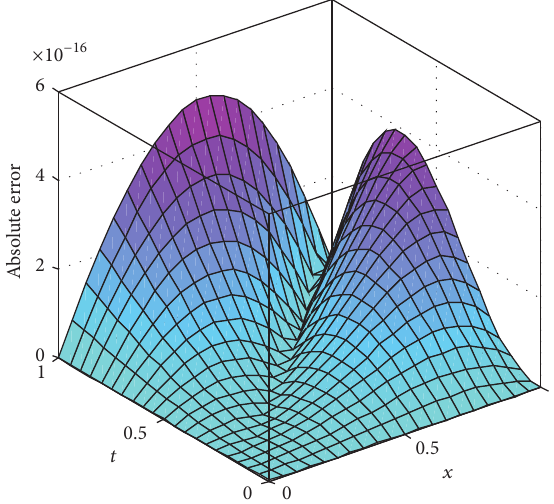
Figure 7: The absolute error for Example 3 with 𝑚 = 5 .